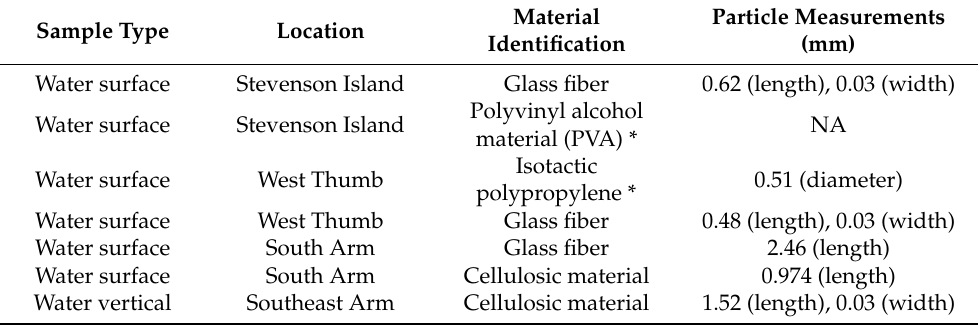
Table 3. Material identification and measurements of 10 particles from Yellowstone Lake, Yellowstone National Park, Wyoming, USA sampled in 2019. Particles were analyzed using either Fourier- transform infrared (FTIR) or Raman spectroscopy. An asterisk (*) denotes a plastic- or rubber- similar